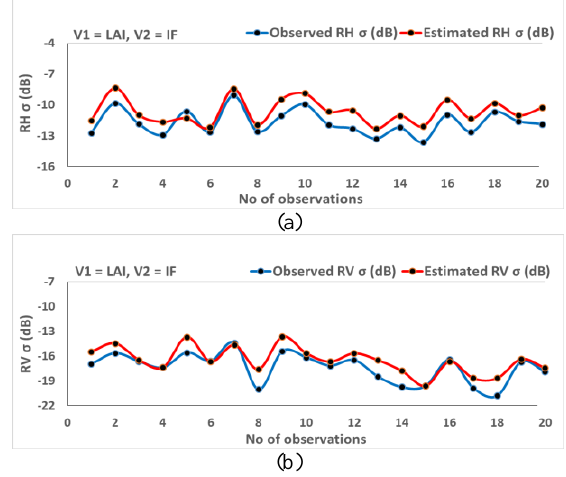
Figure 6. Observed v/s Estimated (a) RH and (b) RV backscatter for Model IV